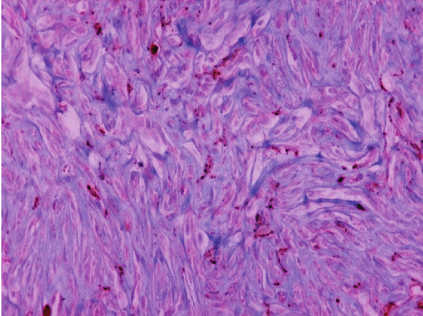
Figure 6: Histiocyte-like tumour cells were positive for CD68 (diaminobenzidine, × 400).